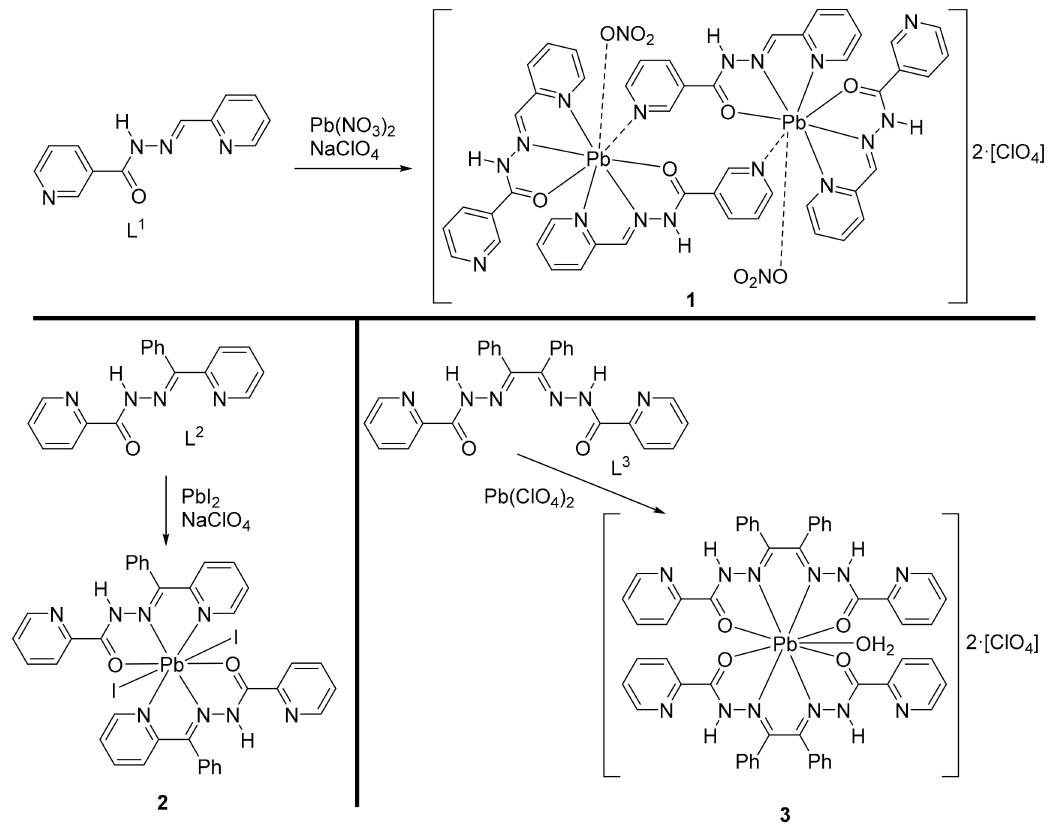
Figure 1. Schematic representation of ligands and Pb(II) coordination compounds ( 1 – 3 ) used in this work and their synthetic